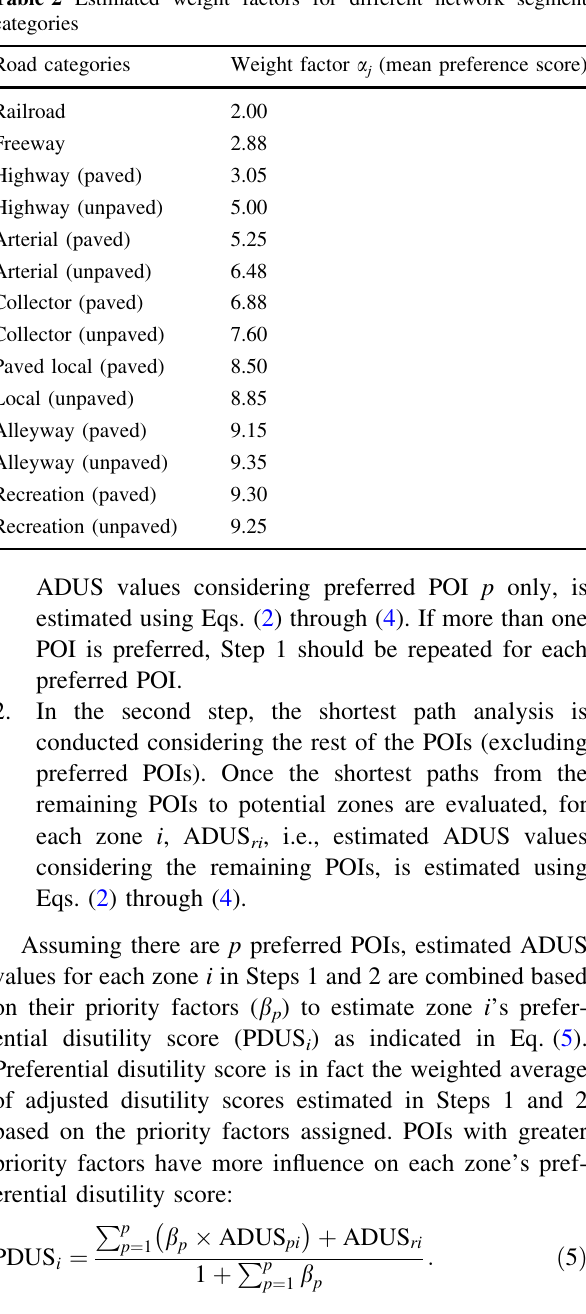
Table 2 Estimated weight factors for different network